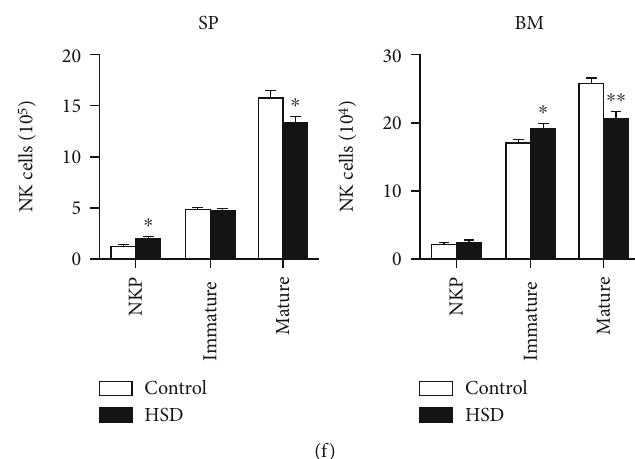
Figure 3: HSD reduced the number of e ff ective NK cells in the spleen and inhibited their maturation in both the spleen and bone marrow. Representative fl ow cytometry pro fi les (a). The percentage (b) and absolute number (c) of NK cell subsets DN (CD27 − CD11b − ), CD27SP (CD27 + CD11b − ), DP (CD27 + CD11b + ), and CD11bSP (CD27 − CD11b + ) in the spleen and BM of control and HSD-fed mice. Representative fl ow cytometry pro fi les (d). The percentage (e) and absolute number of NKp (NK1.1 - CD11b - ), imNK (NK1.1 + CD11b - ), and mNK (NK1.1 + CD11b + ) cells gated on CD3 - CD122 + splenocytes and bone marrow cells of control and HSD-fed mice. All the data represent at least three independent experiments. Data are shown as the means ± SEM . Unpaired Student ’ s t -tests (two-tailed) were performed using the Prism software. A P value of < 0.05 was considered signi fi cant. ∗ P < 0 : 05 , ∗∗ P < 0 : 01